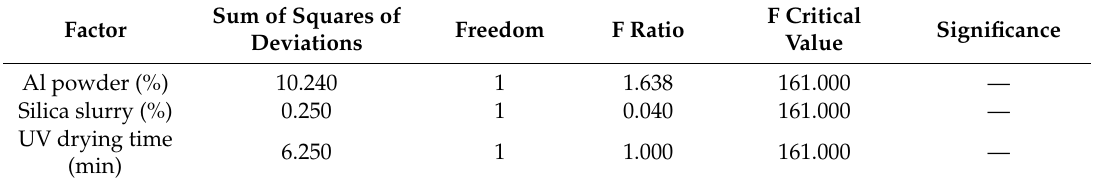
Table 4. F tests.